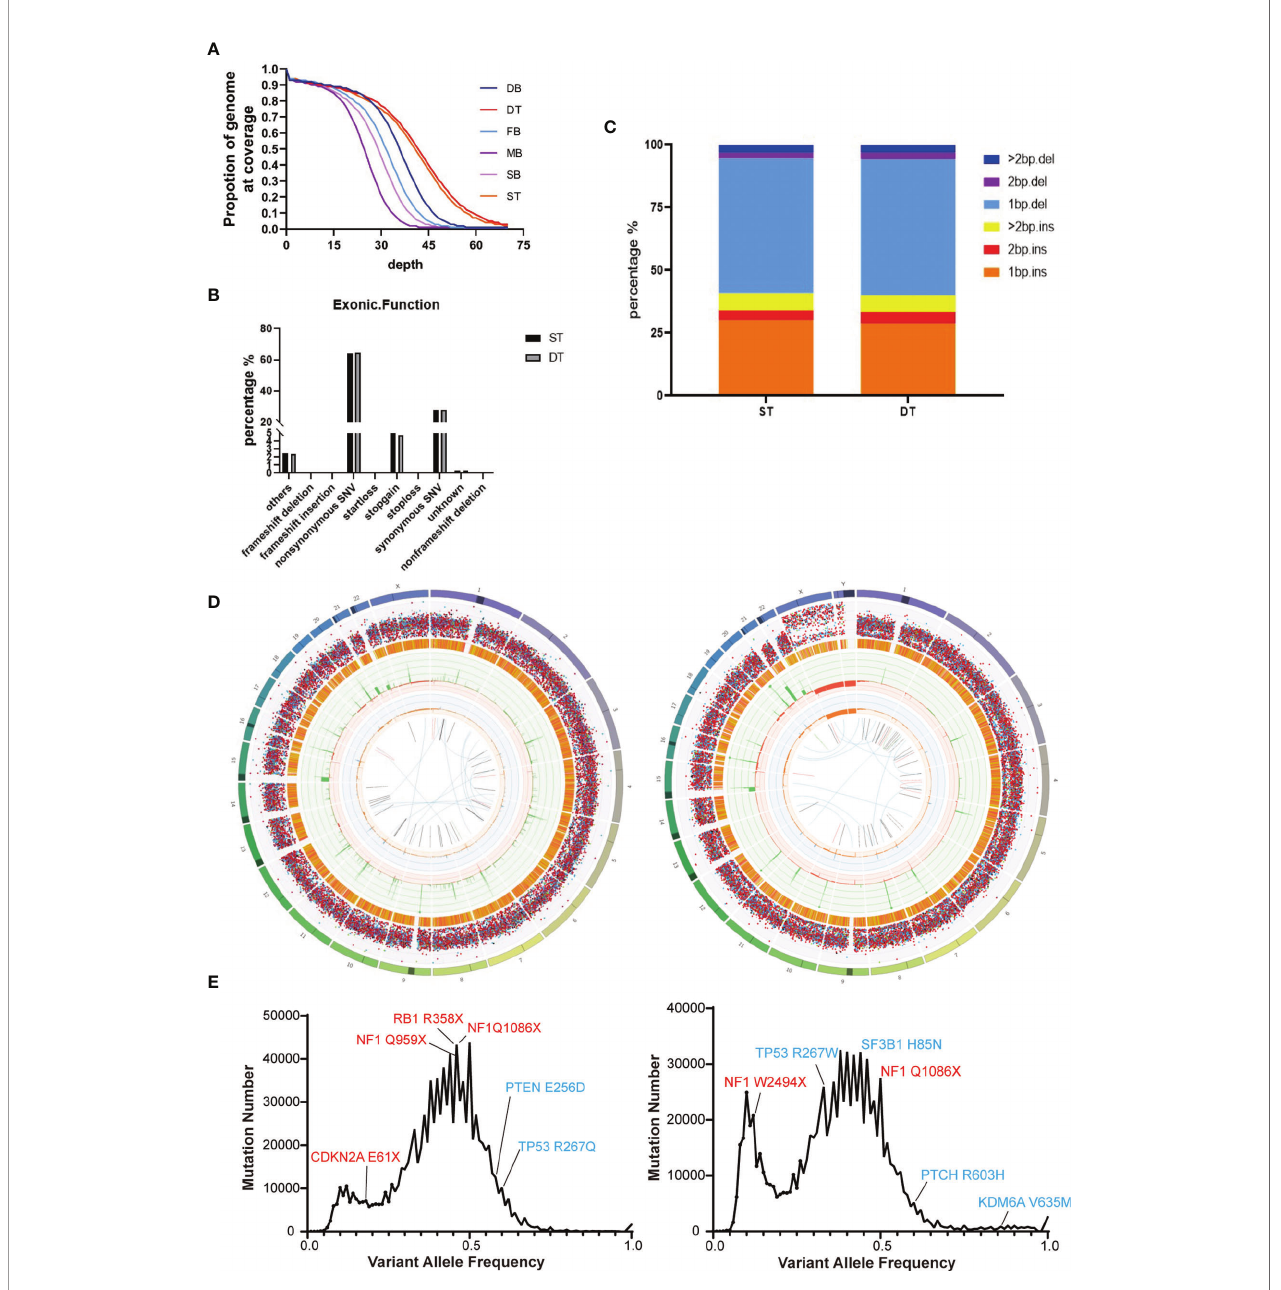
FIGURE 2 | Summary of the whole-genome sequencing results of the two brain tumor cases. (A) Sequencing depth and coverage of the tumor and blood samples. D refers to the female patient (daughter); S refers to the male patient (son); F refers to the patients ’ father; M refers to the patients ’ mother. B refers to blood samples. T refers to tumor tissue. (B) The proportion of different somatic mutation types in exons. (C) The distribution of somatic Indel length. (D) Circos plots of the female ’ s (left) and the male ’ s (right) brain tumor tissue illustrated distributions of all exonic mutations across the chromosomes. The outer fi rst circle showed the chromosomes and the darker shaded areas represented large gaps. The second circle showed the somatic variants and each dot represented a single somatic variant. The third circle showed all observed tumor purity adjusted copy number changes, including both focal and chromosomal somatic events. The fourth circle represented the observed minor allele copy numbers across the chromosome. The innermost circle displayed the observed structural variants within the chromosomes. (E) Mutation number vs. Variant allele frequency (VAF) plot of the female ’ s (left) and the male ’ s (right) brain tumor tissue. Potential driver mutations are labeled (Red: Truncation mutation; Blue: Non-synonymous